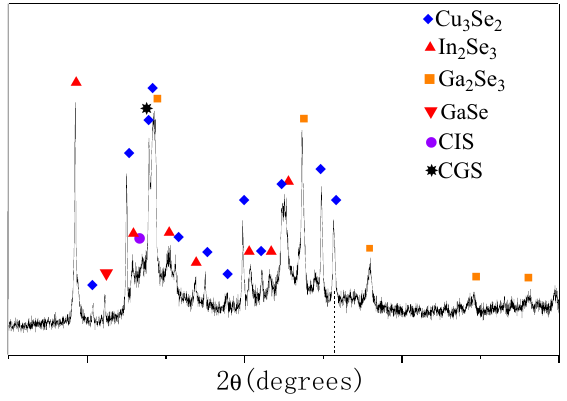
Figure 3. The X-ray diffraction patterns of the Cu 2 Se, In 2 Se 3 , and Ga 2 Se 3 mixtures milled for 2 h.